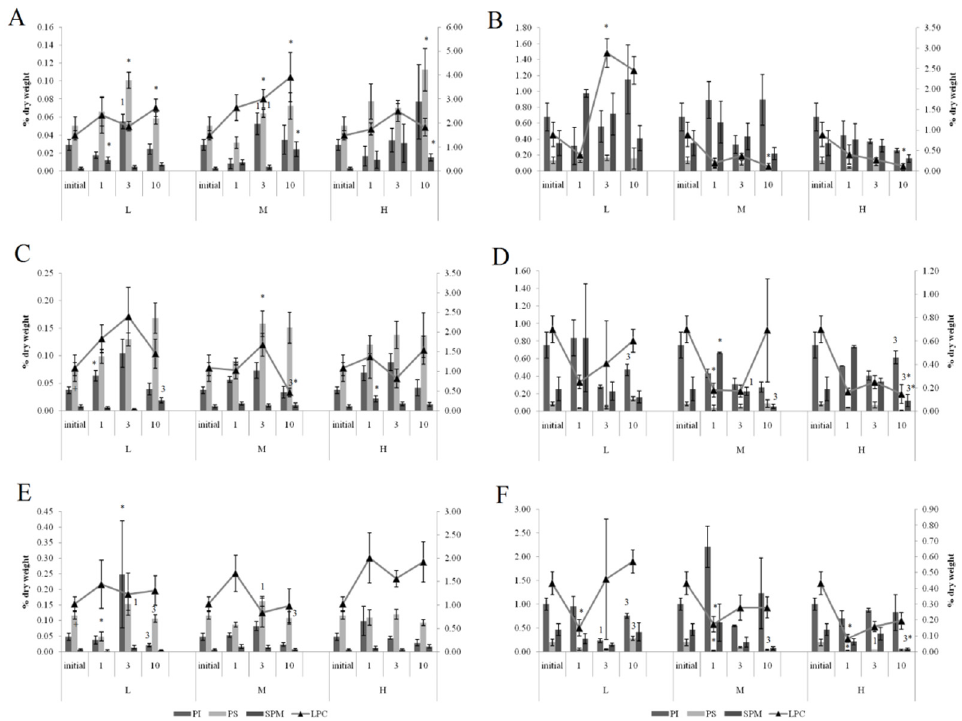
Figure 6. The content of some minor phospholipids and lysophosphatidylcholine (LPC) in gills ( A , C , E ) and digestive glands ( B , D , F ) of horse mussels ( A , B ) and blue mussels ( C , D ) low salinity; ( E , F ) normal salinity) under low (L), medium (M), and high (H) crude oil concentrations. Values are means ± standard error ( n = 5). * significant results in comparison with initial level; 1, 3—significant results in comparison with first and third days of exposure. Differences were estimated by the nonparametric Kruskal–Wallis test, p < 0.05 + significant differences between mussels acclimated to 15 and 25 psu were estimated by the nonparametric Mann–Whitney U test, p < 0.05.